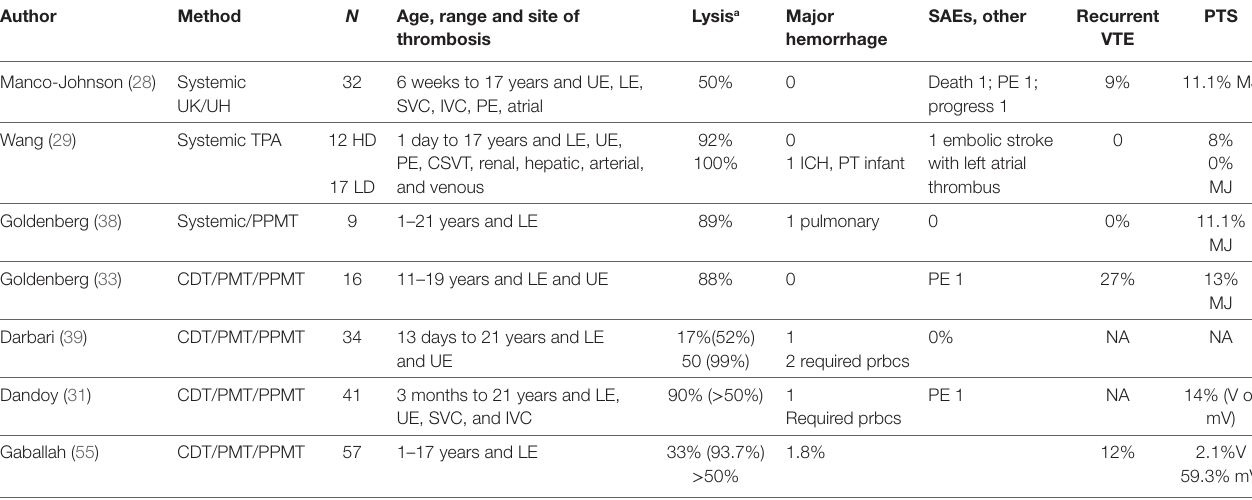
TABLe 1 | Published results of thrombolysis in children.